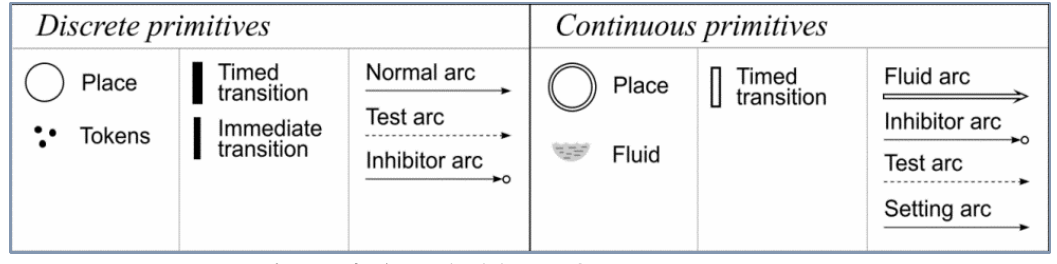
Figure 1 . All primitives оf a SHPN